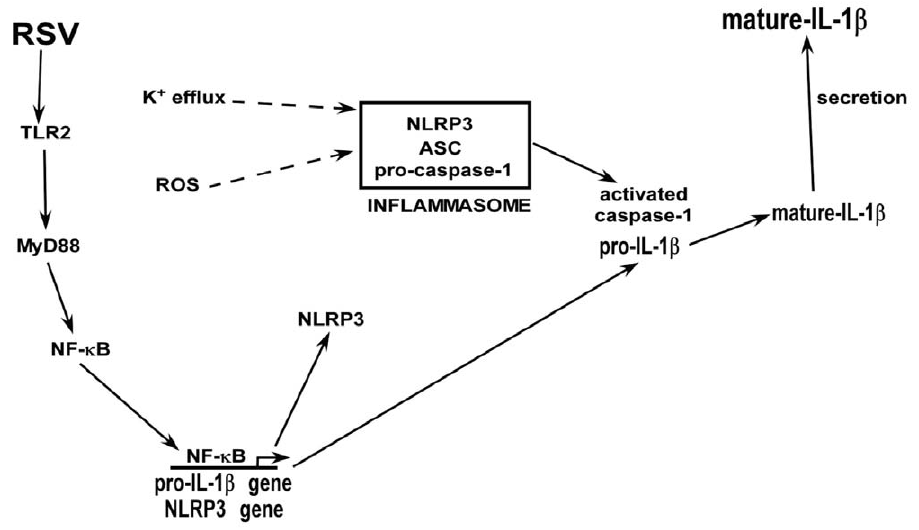
Figure 9. A schematic model depicting the mechanism of IL-1 b secretion during RSV infection. RSV infection activates TLR2/MyD88 pathway that culminates in NF- k B activation. Nuclear translocation of NF- k B results in NF- k B mediated trans-activation of pro-IL-1 b and NLRP3 genes. Intracellular ROS generated during RSV infection and potassium efflux due to stimulation of ATP-sensitive ion channel triggers assembly of NLRP3/ ASC inflammasome complex. NLRP3/ASC inflammasome activates caspase-1, which subsequently cleaves pro-IL-1 b protein into its mature form. Mature IL-1 b is secreted from the cells.